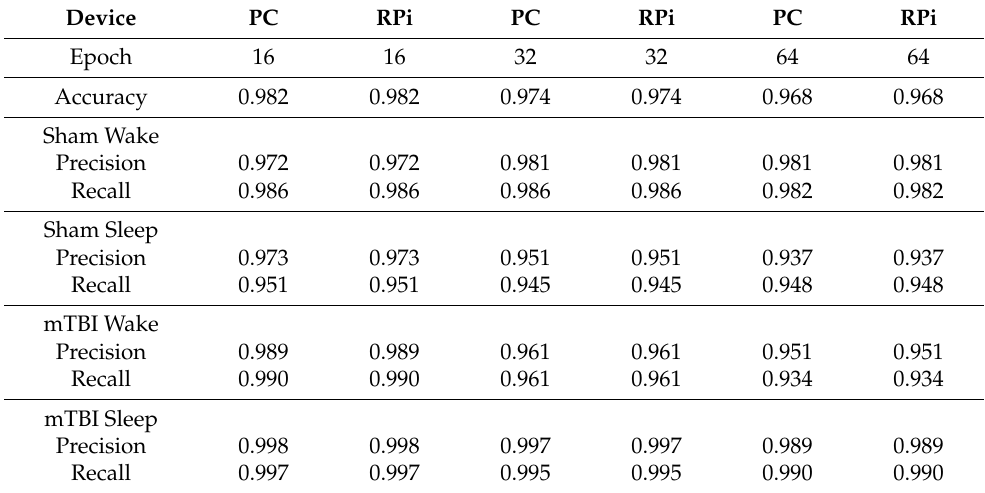
Table 1. System performance comparison of RPi with HPC with 4 classes using XGBoost.